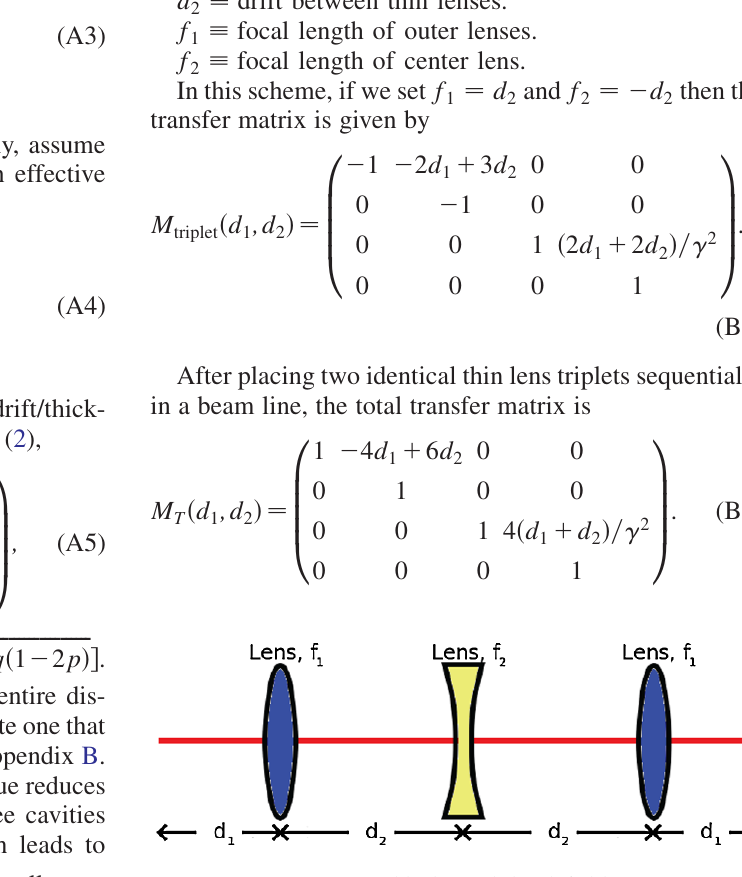
FIG. 12. Thin lens triplet